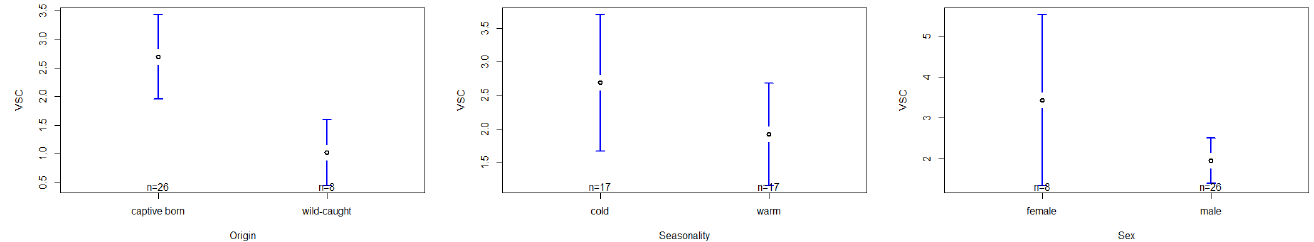
Figure 2. Confidence interval plots of the VSC and all significant fixed factors (seasonality, sex and